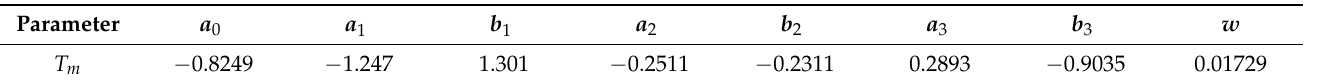
Table 2. The precision of improved ZHD in the Yangtze River Delta region during the 2016–2020 period (mm).